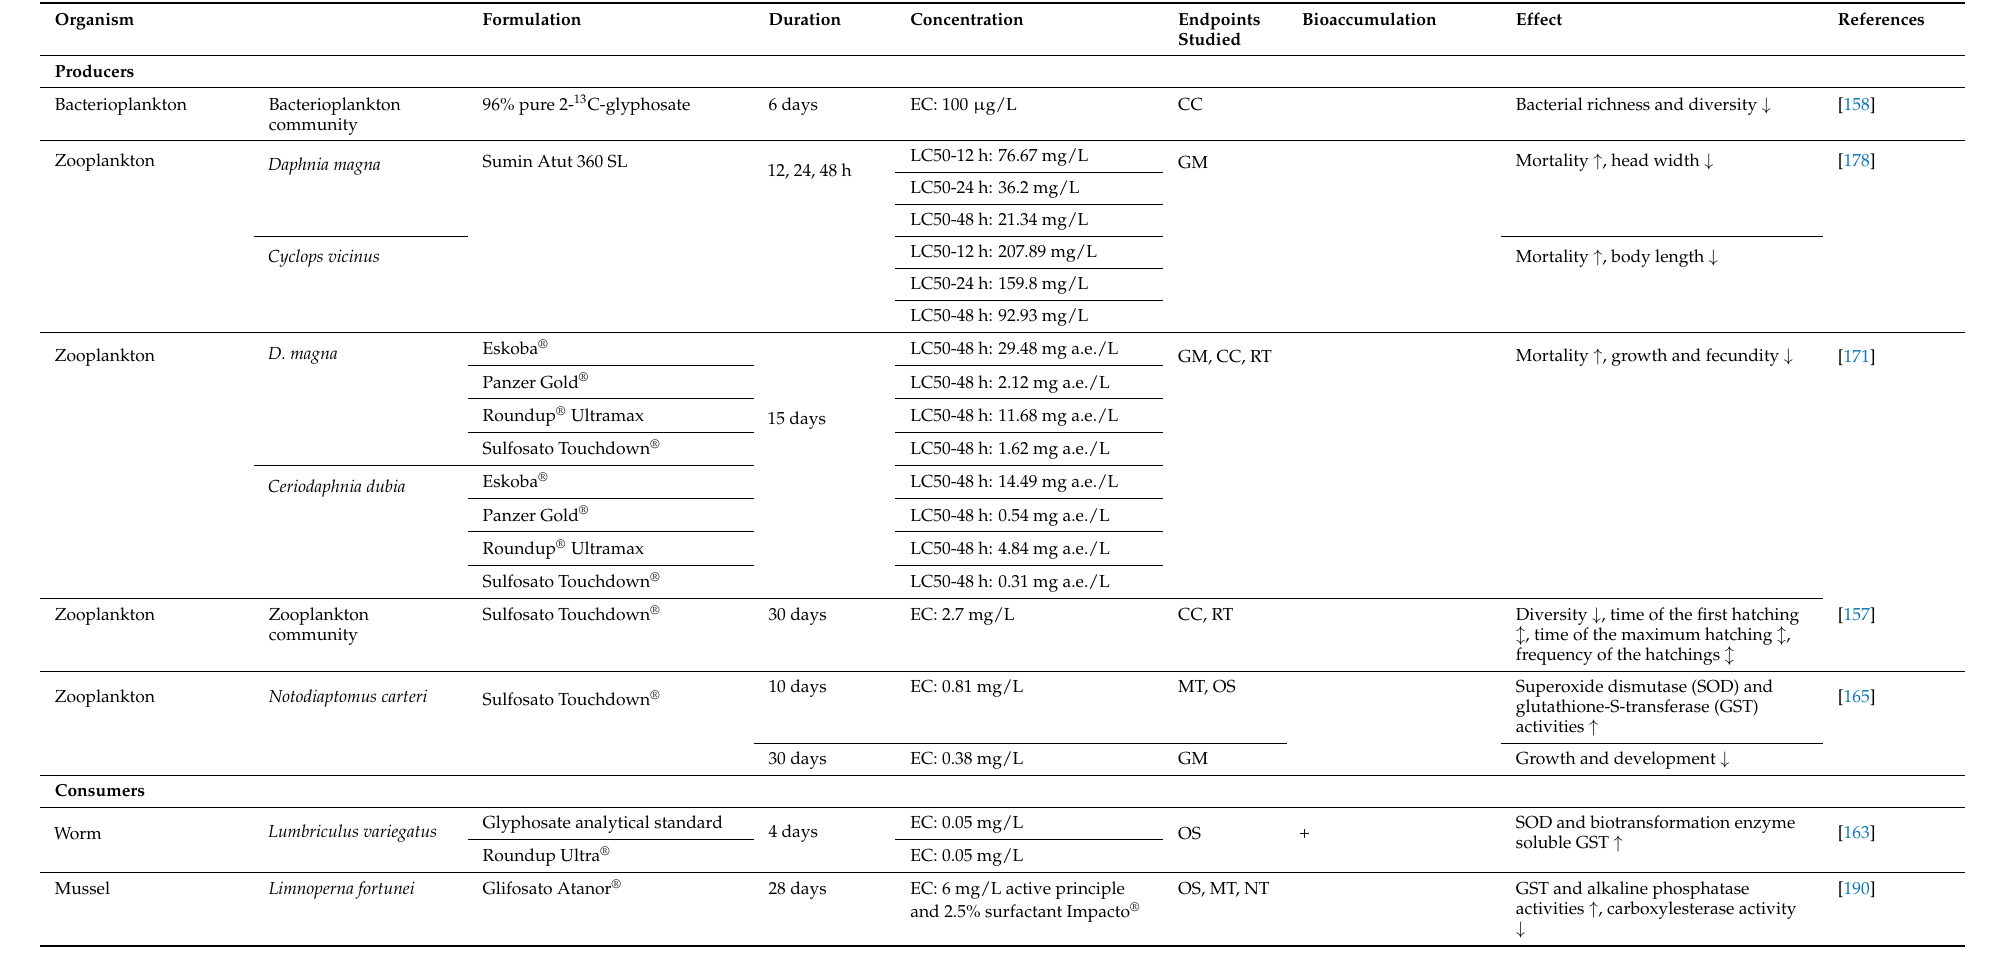
Table 1. Studies of the toxic effects of glyphosate and its commercial formulations on organisms from different trophic levels. CC = community composition, GM = growth and mortality, RT = reproductive toxicity, MT = metabolic toxicity, OS = oxidative stress, NT = neurotoxicity, GE = gene expression, MM = microbiome modulation, HT = haemotoxicity, BC = behavior change, GT = genotoxicity, CT = cytotoxicity, HP = histopathology, IT = Immunotoxicity, ET = endocrine toxicity, ↑ = Increased, ↓ = Decreased, (cid:108) =